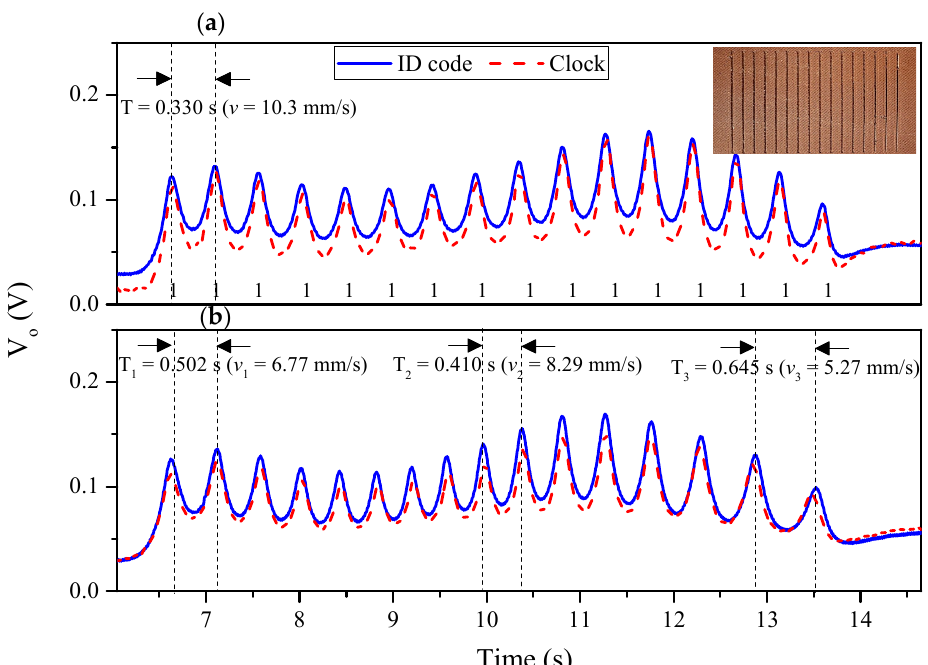
Figure 9. Photograph and measured envelope functions (ID code and clock signals) of the 3D-printed 16-bit encoder with all the apertures present at their positions, inferred by considering encoder motion with ( a ) constant velocity and with ( b ) constant acceleration.